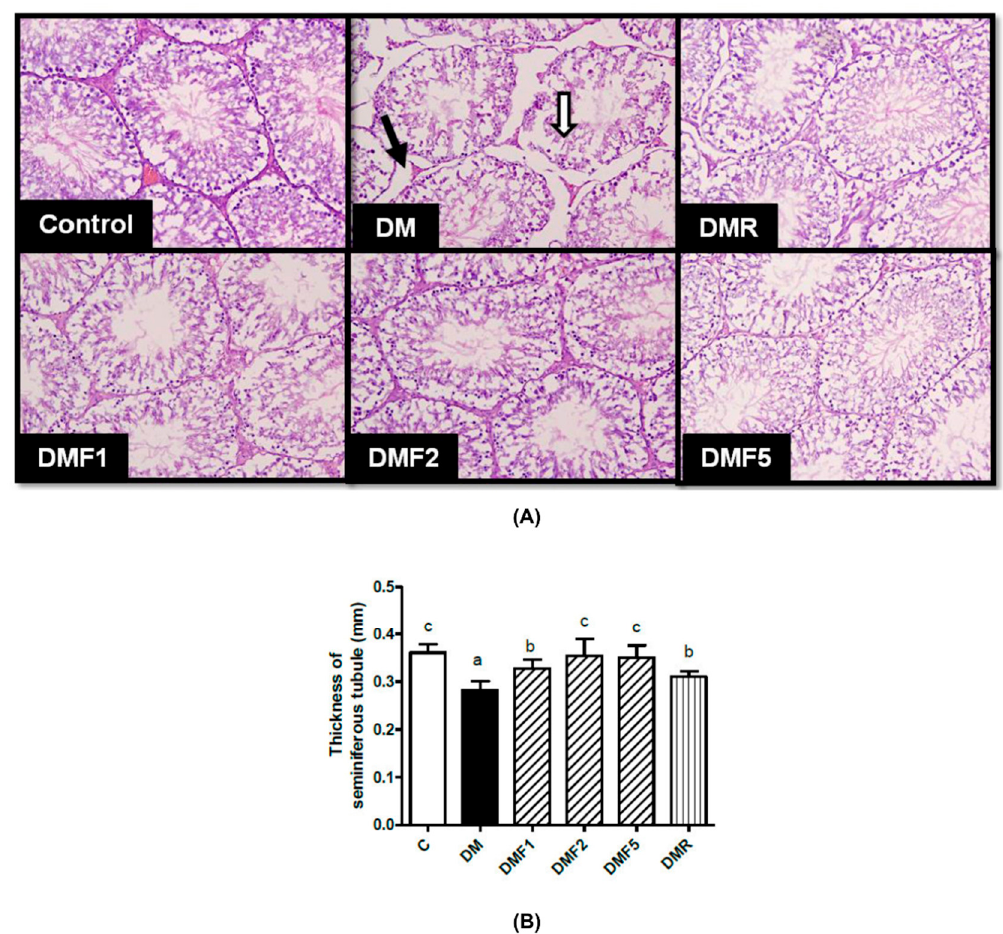
Figure 8. Effects of fucoxanthin on ( A ) testicular morphology and ( B ) thickness of seminiferous tubule diameter after treatment for four weeks. Data are shown as the mean ± S.D. ( n = 5). The values with different letters (a–c) represent significant differences ( p < 0.05) as analyzed by Duncan’s multiple range test. Black arrow, Leydig cell; white arrow, Sertoli cell; C, control; DM, diabetes; DMF, diabetes treated with fucoxanthin; DMR, diabetes treated with rosiglitazone.